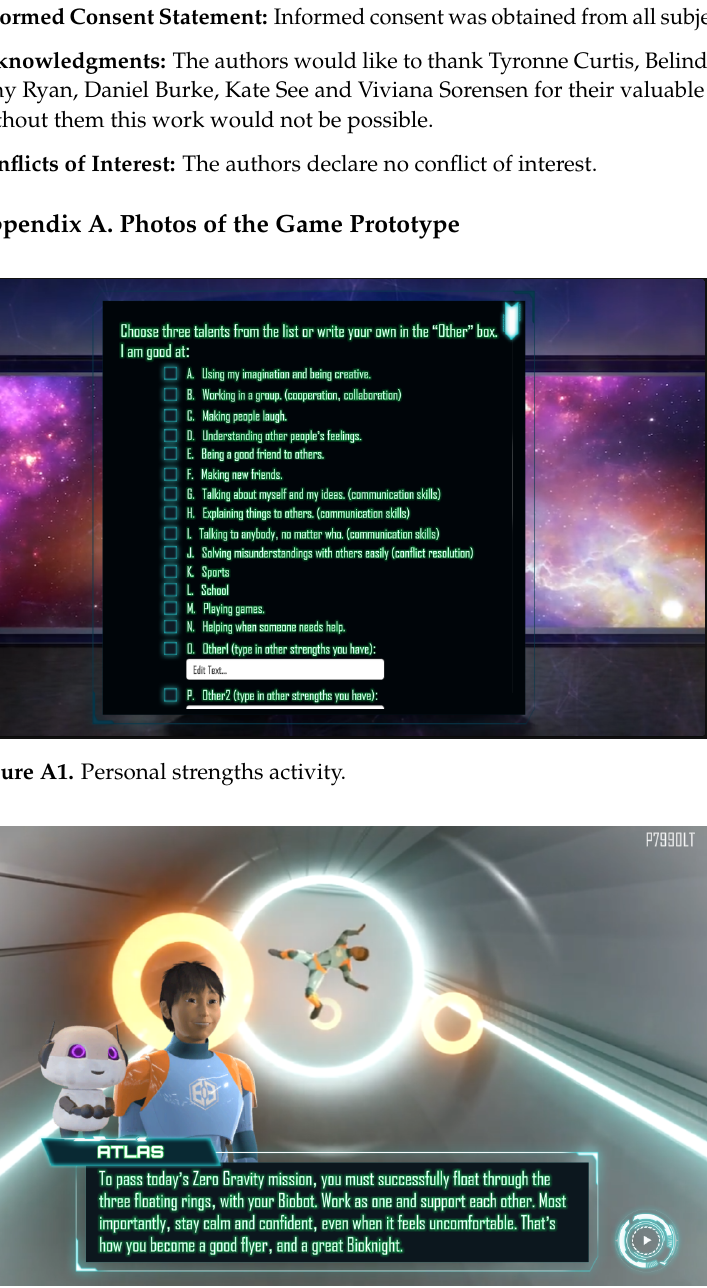
Figure A2. Example dialogue screen.